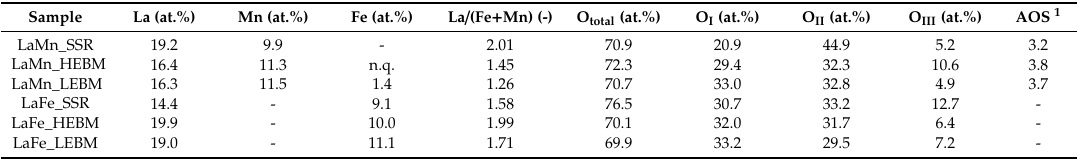
Table 3. Quantification from X-ray photoelectron spectroscopy (XPS) analysis for LaMnO 3.15 and LaFeO 3